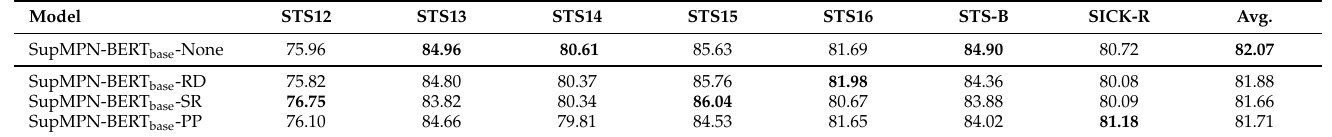
Table A1. Result of applying various text augmentation techniques for creating positive pairs on STS tasks. In each column, values greater than our implementation (None option) is in